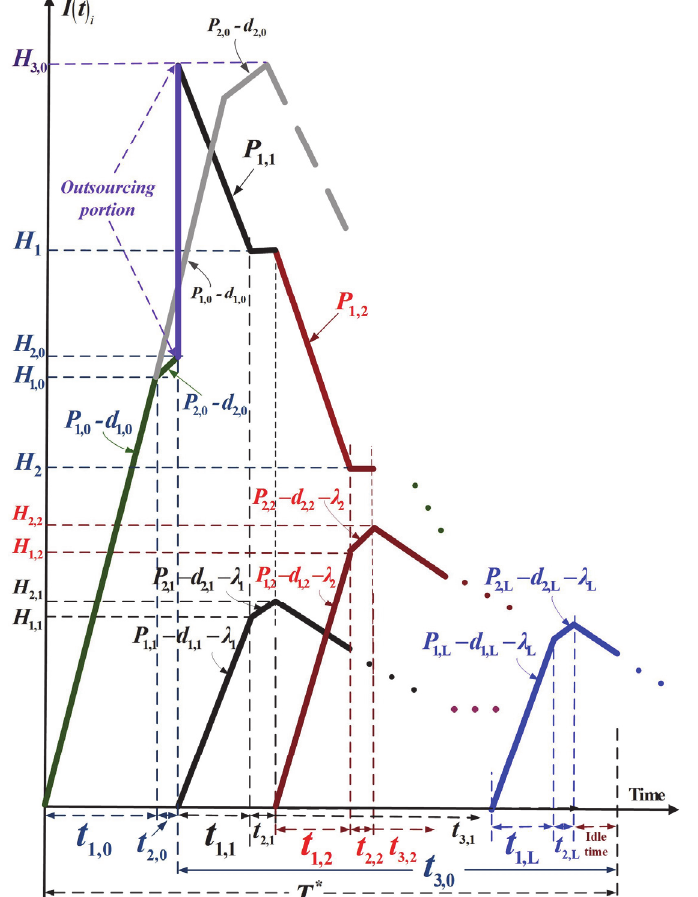
Fig. 1. The inventory level in the proposed multi-item batch fabrication model with delayed product differentiation, outsourcing, and quality assurance as compared with the same system without outsourcing policy (in